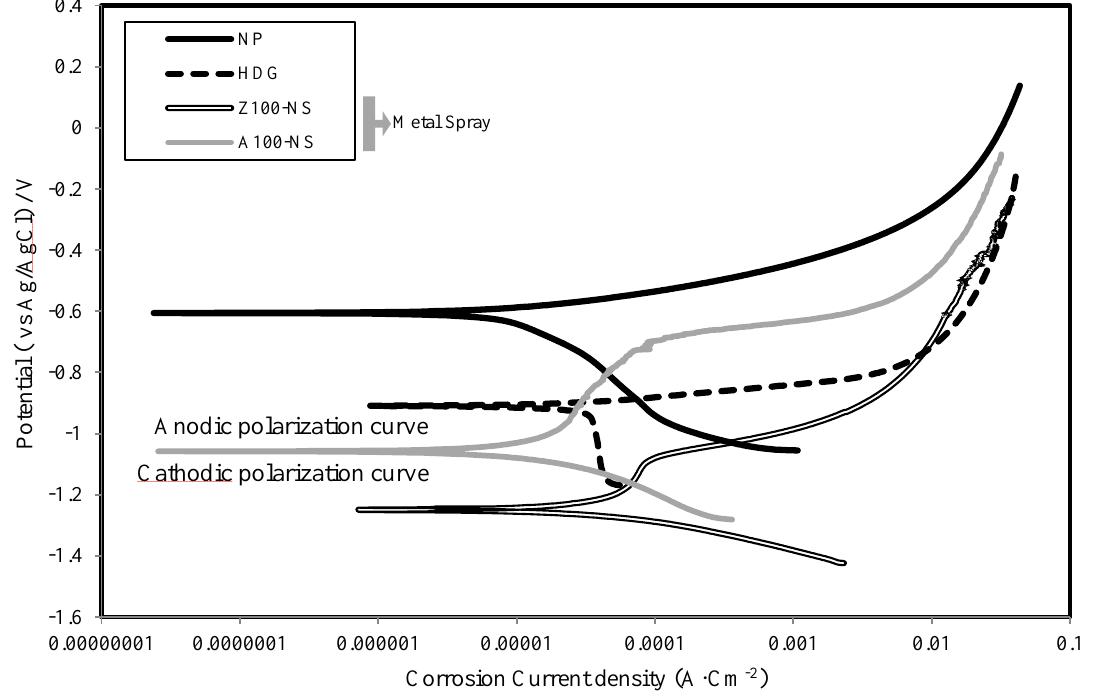
Figure 5. Polarization curves of NP, HDG, Z100-NS and Al100-NS